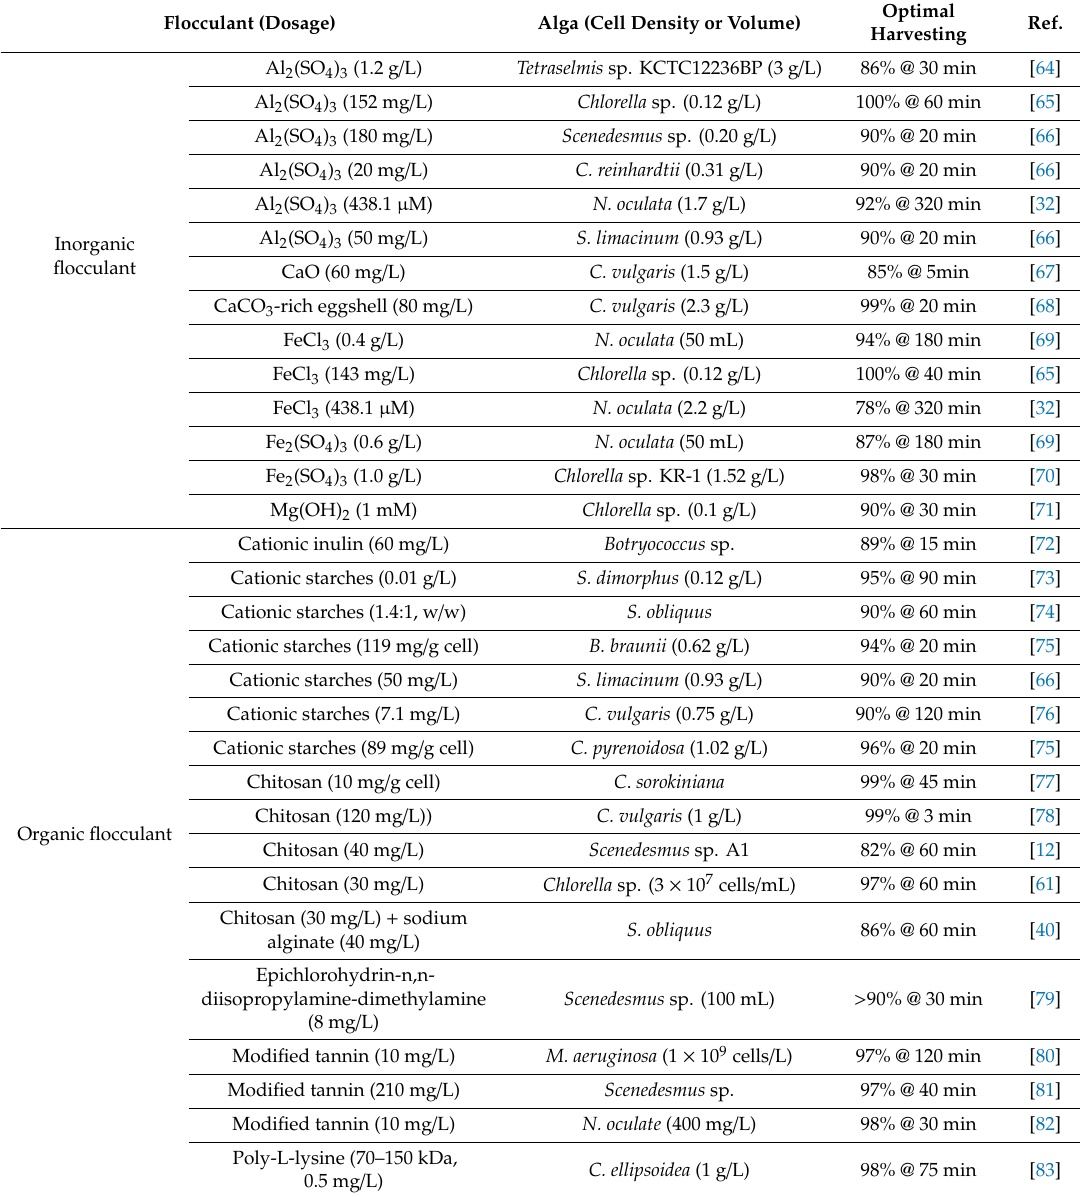
Table 3. Comparison of inorganic and organic chemical flocculants for algae